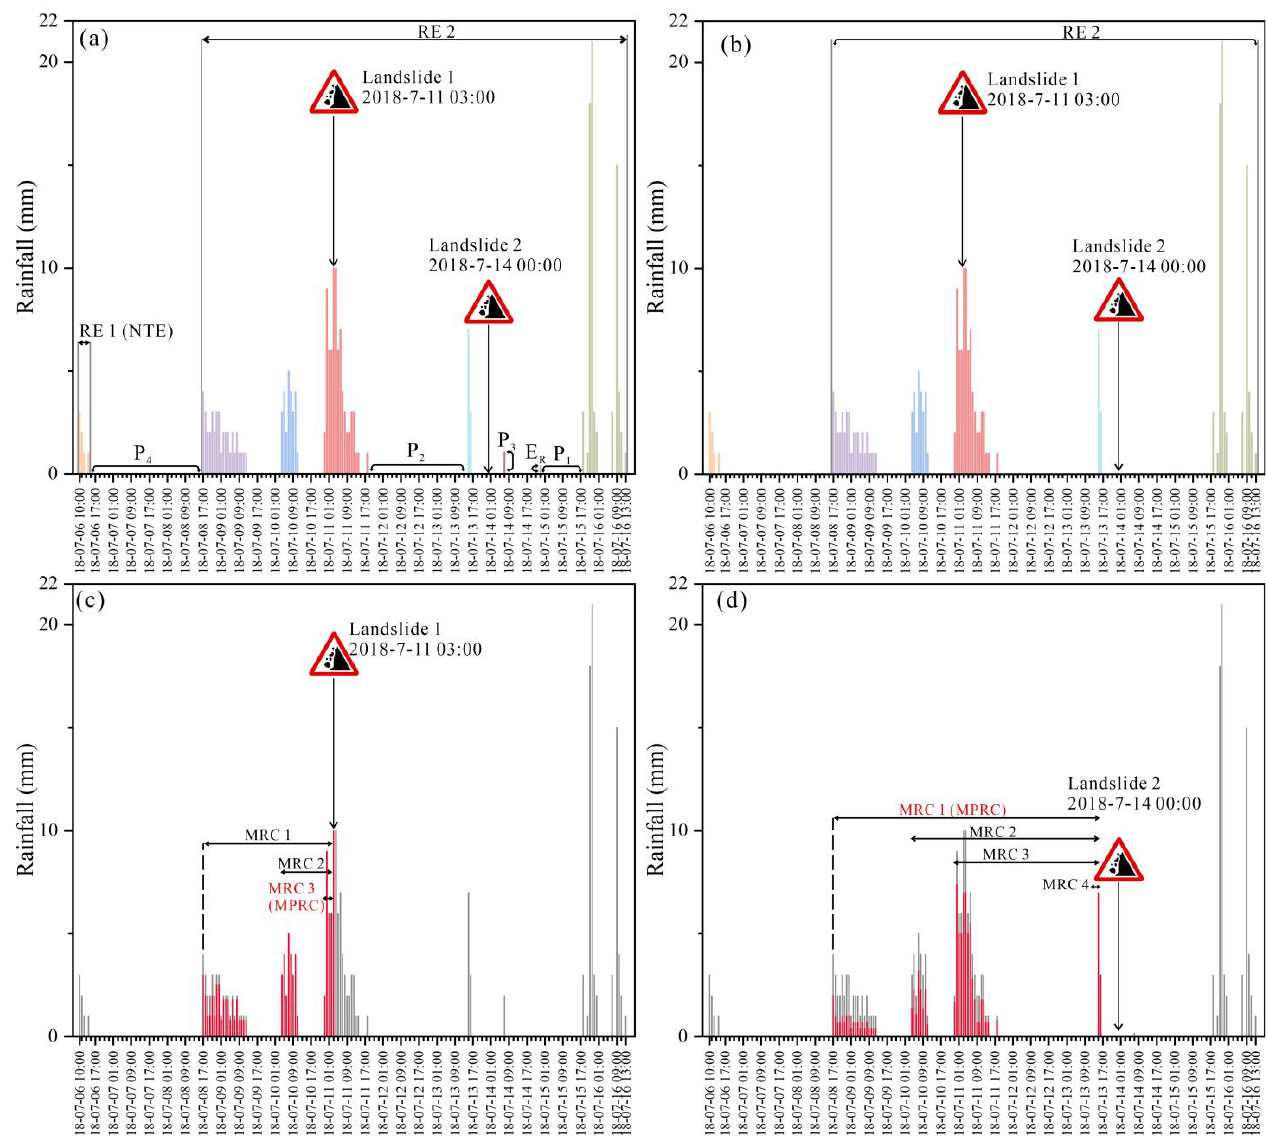
Figure 4. Example of the reconstruction of REs, NTEs, MRCs, and MPRCs. ( a ) Hourly rainfall measurements of Heihaba rain gauge from 6th to 16th July 2018; bars with different colors are the identified rainfall sub-events. ( b ) Selection of the rainfall event associated with landslides (RE 2), ( c ) reconstruction of MRCs and MPRC for the first landslide; red bars are the computed event rainfall of MRCs, and ( d ) reconstruction of MRCs and MPRC for the second landslide. Table 1. Input parameters of CRTL-T adopted in this study.